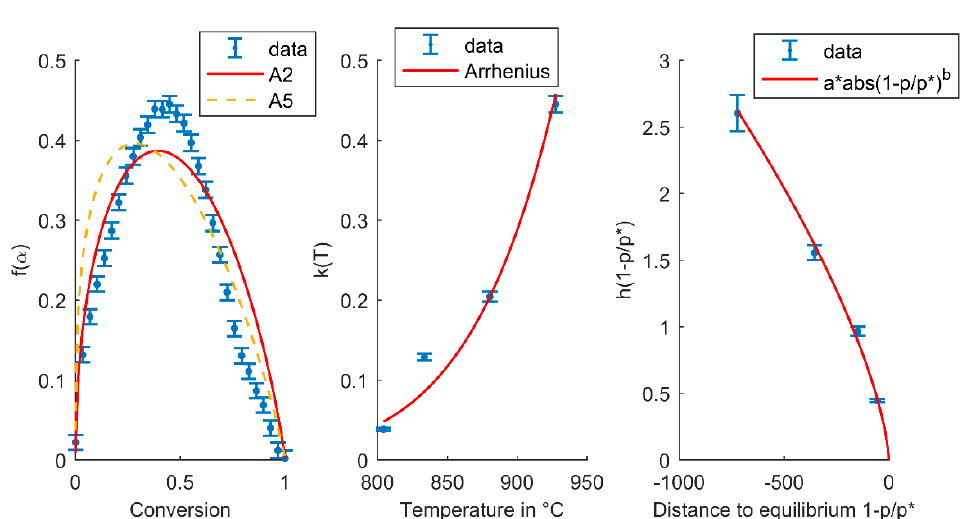
Figure 12. Reparameterization of pressure for considering the distance to the equilibrium curve in the general kinetic equation.